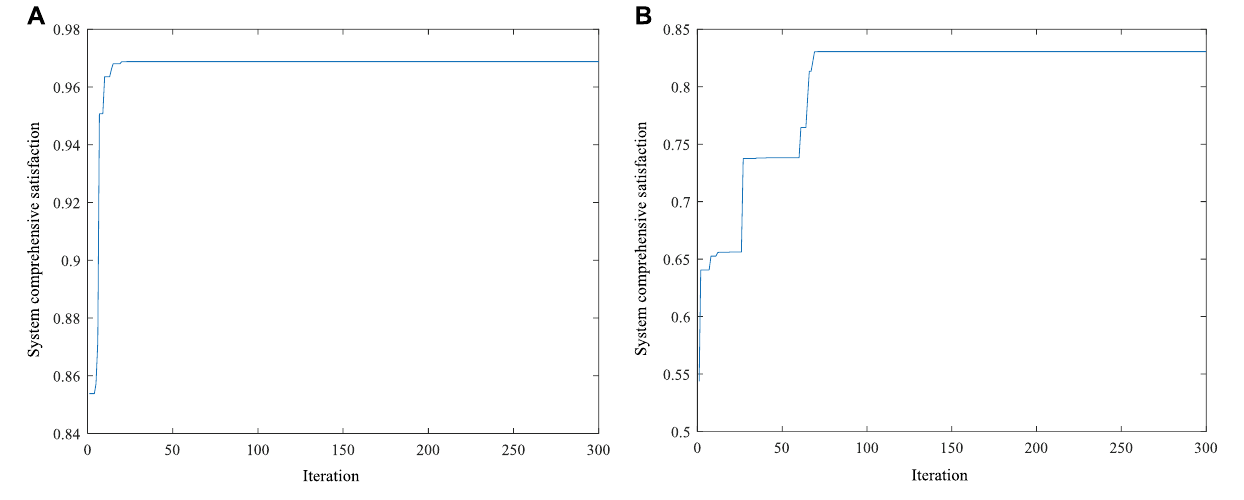
Frontiers in Energy Research |